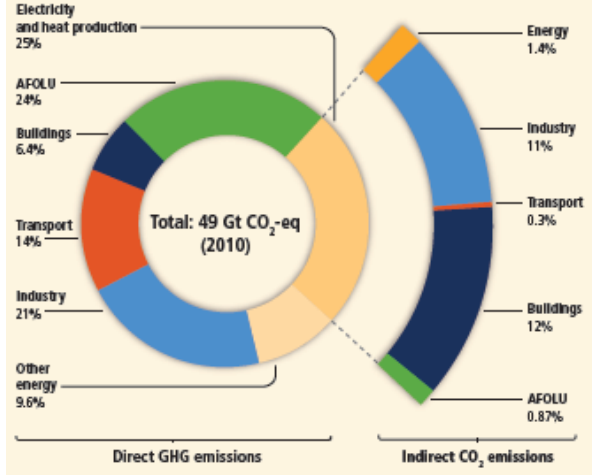
Figure 5. Total anthropogenic GHG emissions in GtCO 2 -eq/ yr) from different economic sectors in 2010. The circle shows the shares of direct GHG emissions in percentage of total emissions form the five main economic sectors. The pullout shows how shares of indirect CO 2 emissions from electricity and heat production are attributed to sectors of final energy use (IPCC,